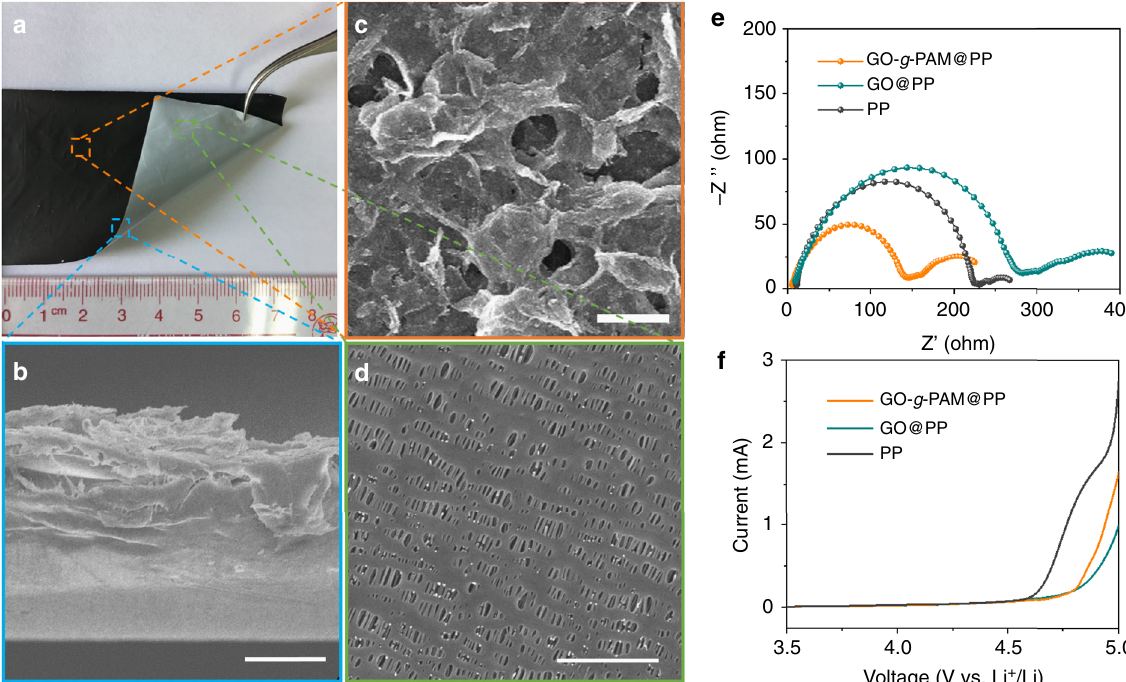
Fig. 3 Characterization of the GO- g -PAM@PP separator. a Digital photograph of a bent GO- g -PAM@PP separator. b Cross-section and ( c ) top-view SEM images of the GO- g -PAM@PP separator. d SEM image of the uncoated side of the GO- g -PAM@PP separator. e Nyquist plots of symmetric Li|Li cells with PP, GO@PP, and GO- g -PAM@PP separators. f LSV curves of asymmetric Li|stainless-steel cells with PP, GO@PP, and GO- g -PAM@PP separators at a scan rate of 5 mV s − 1 . Scale bars: ( b ) 20 μ m, ( c ) 5 μ m, and ( d ) 1 μ